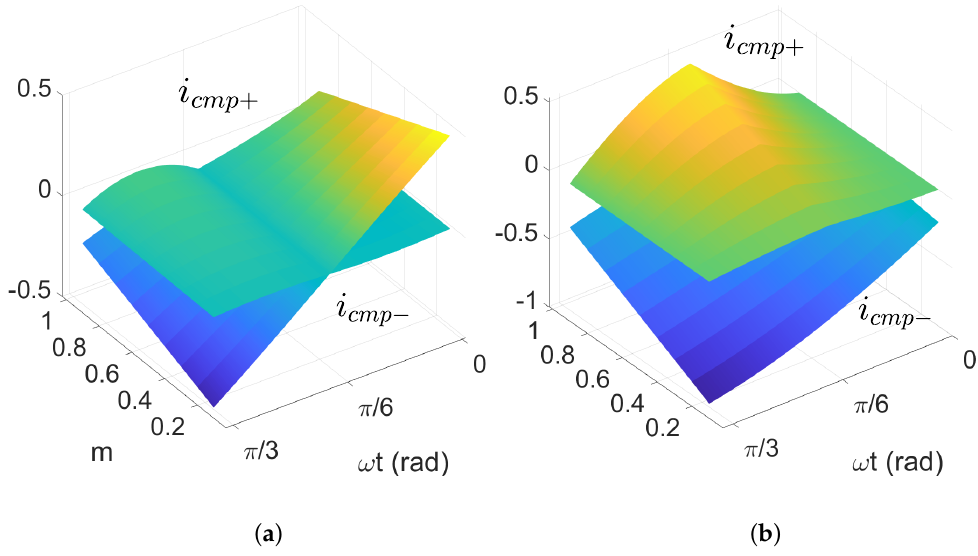
Figure 14. Positive and negative compensating currents in Sector I when ( a ) φ = 0, ( b ) φ = π /4.